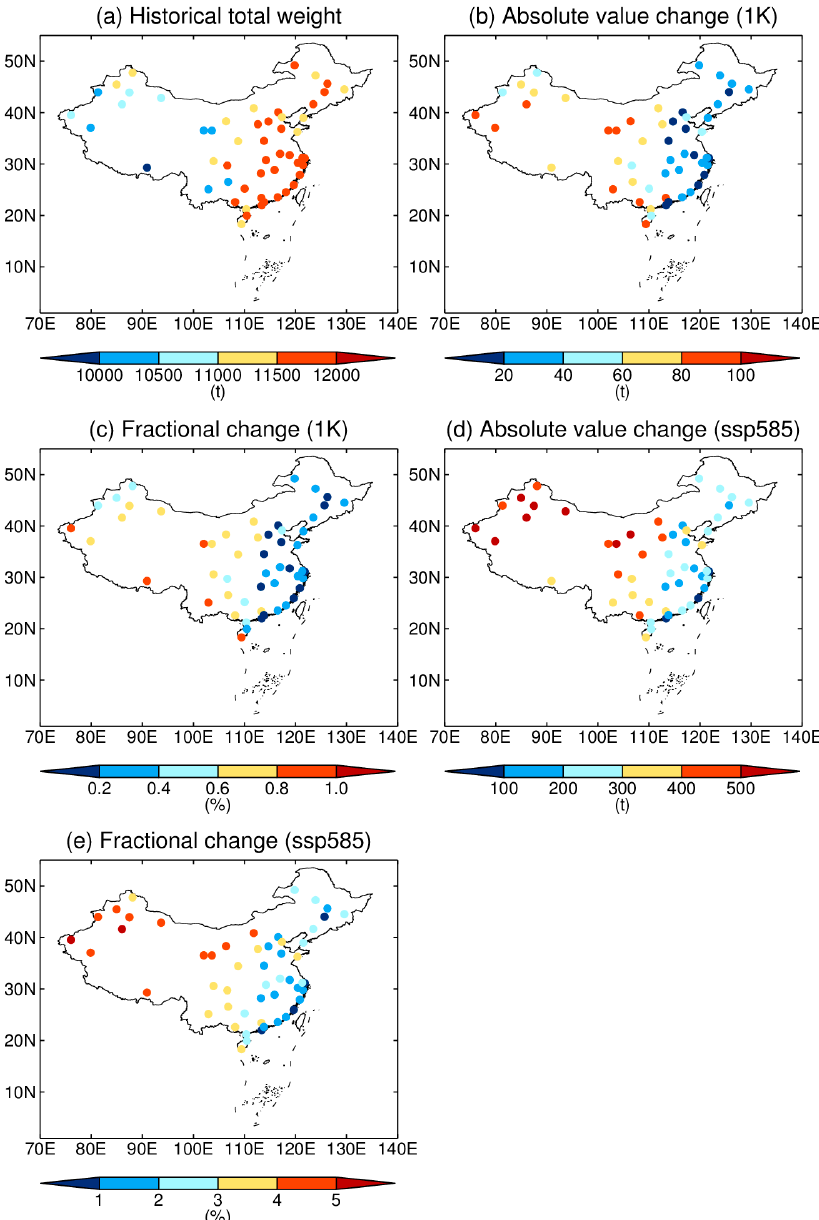
Figure 4. ( a ) The total summer carry capacity (units: ton) of one Boeing 737-800 in the current climate. ( b ) The absolute change and ( c ) fractional change of total summer carry capacity under the uniform 1 °C warming. ( d ) The absolute change and ( e ) fractional change of total summer carry capacity in 2091–2100 relative to 2005–2014 under the SSP5-8.5 warming scenario. The plotted data is tabularized in Table S4.